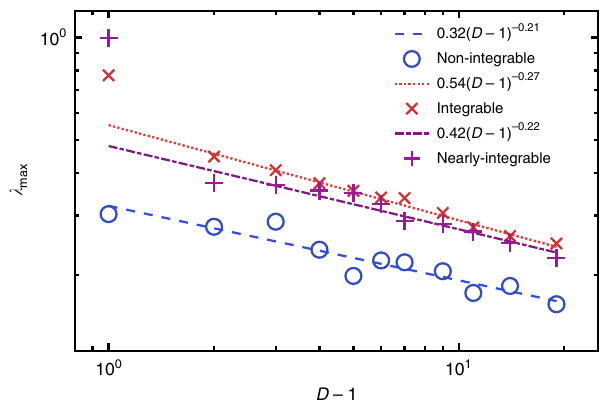
Fig. 2 Maximum Lyapunov exponent versus bond order. The maximum Lyapunov exponent depends strongly upon the projection nonlinearities at different bond orders, tending to zero in the limit D → ∞ . Here, we show the largest exponent varying with bond order for non-integrable (circles), integrable (crosses) and nearly integrable (pluses) systems. The largest exponent decreases like λ max ( D ) = 0.32( D − 1) − 0.21 for non-integrable systems, λ max ( D ) = 0.54( D − 1) − 0.27 for integrable systems and λ max ( D ) = 0.42( D − 1) − 0.22 for nearly integrable systems